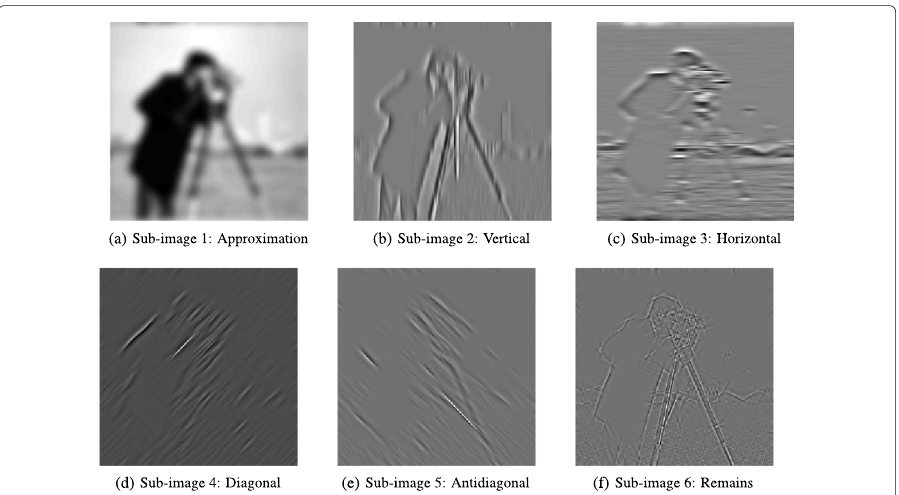
Fig. 15 Rescaled sub-images1–6 of the “Cameraman” image produced by the “ SSA-iSBD6-channelfilterbank ” with L =